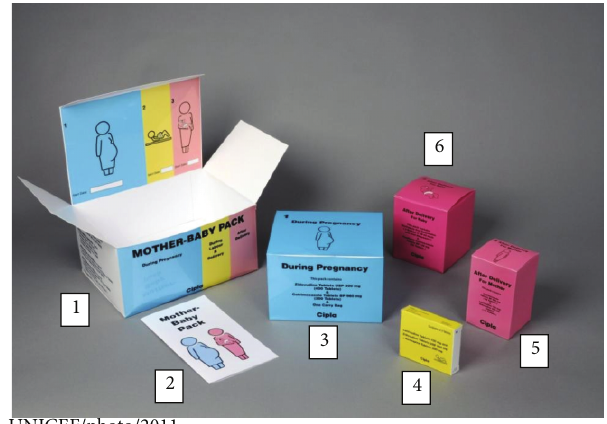
Figure 1: The pack and its inner boxes and instruction sheet. Coun- terclockwise from the left. (1) Outer pack identical for all women (size: 255 mm × 182 mm × 130 mm). (2) Instruction sheet written in Sesotho. (3) Blue inner box containing medicine to be taken during pregnancy: (i) ferrous sulphate, folic acid, and Vitamin B-complex for all women; (ii) Zidovudine (AZT) for HIV-positive women on ARV prophylaxis. (4) Yellow inner box containing medicine to be taken during delivery: (i) AZT/Lamivudine (3TC) in fixed dose combination and Nevirapine tablets for HIV-positive women on ARV prophylaxis. (5) Pink inner box containing medicine for the mother to be taken postpartum: (i) AZT/3TC 7-day “tail” in fixed dose combination for HIV-positive women on ARV prophylaxis; (ii) vitamin A for all women. (6) Pink inner box containing medicine for the infant through six weeks of age: (i) Nevirapine syrup and syringe for administration for HIV-positive women on prophylaxis and